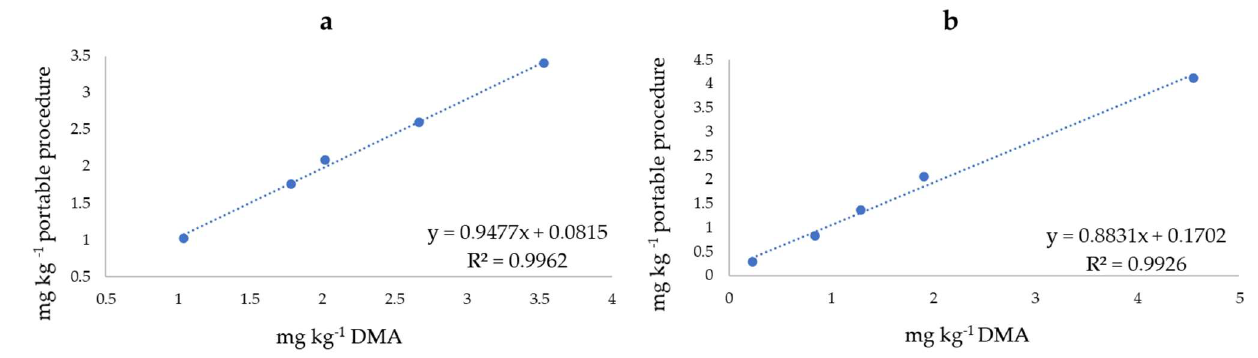
Figure 3. Correlation between the concentrations (mg kg −1 ) of ( a ) Hg TOT and ( b ) CH 3 Hg obtained using the portable procedure and DMA. ● = samples (tuna fish 2, tuna fish 1, blue marlin, swordfish 1 and swordfish 2, reported in ascending order of concentration).